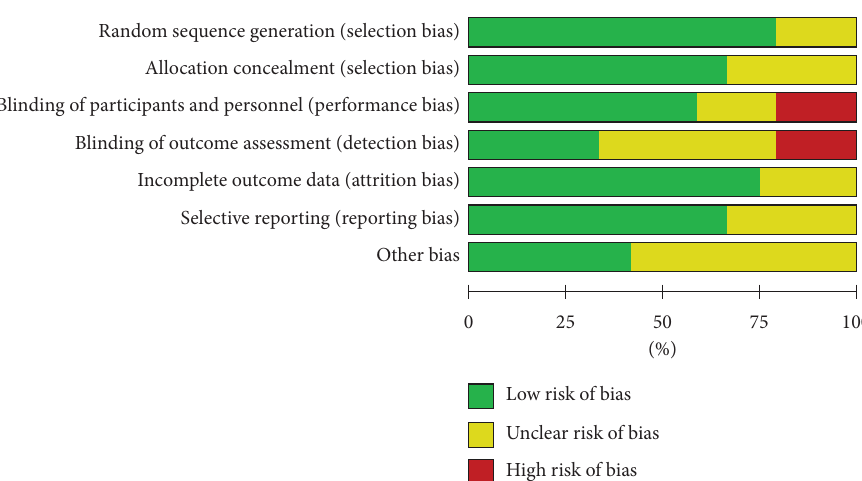
Figure 2: Risk assessment graph according to the Cochrane risk assessment tool.